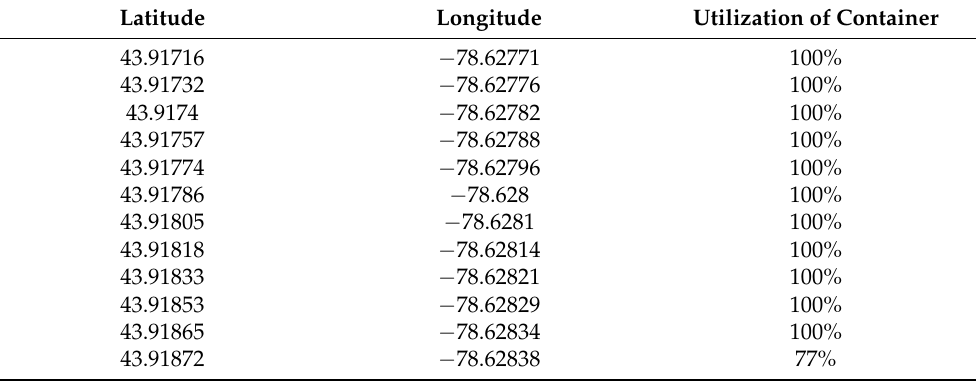
Table 8. All of the assigned containers are fully utilized. Note that while the last container has 77% utilization, this is because the remaining number of apples was 230 at that point, not 300, so 77% is the maximum utilization the container can reach.